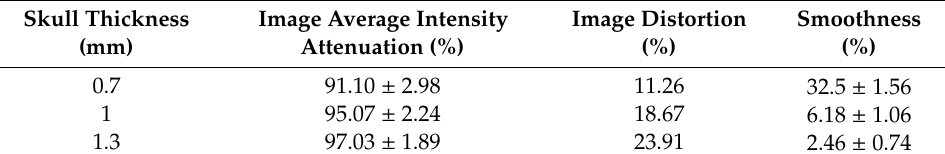
Table 3. Summary of the quantitative evaluation of the PA imaging through the skull in gelatin with the fiber mixture when the light illumination path is blocked with di ff erent thicknesses of skull.